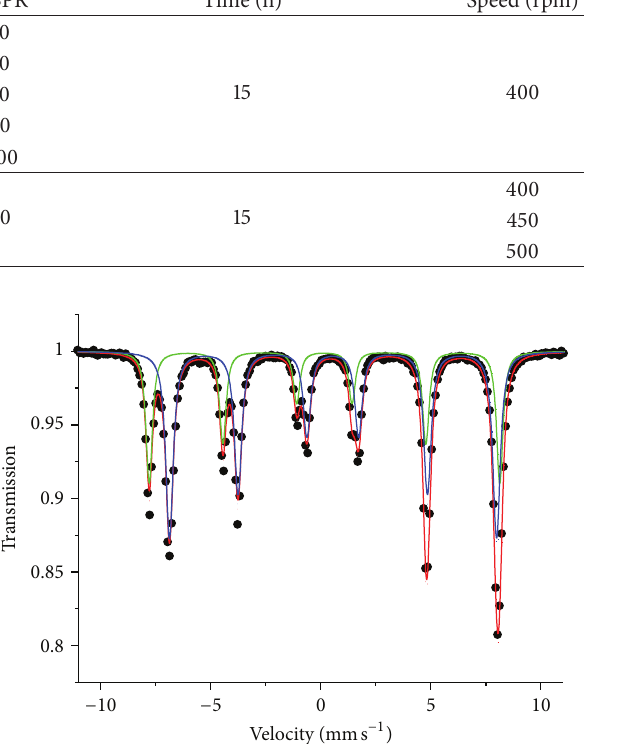
Figure 1: Room temperature MAS spectrum of commercial sourced magnetite.